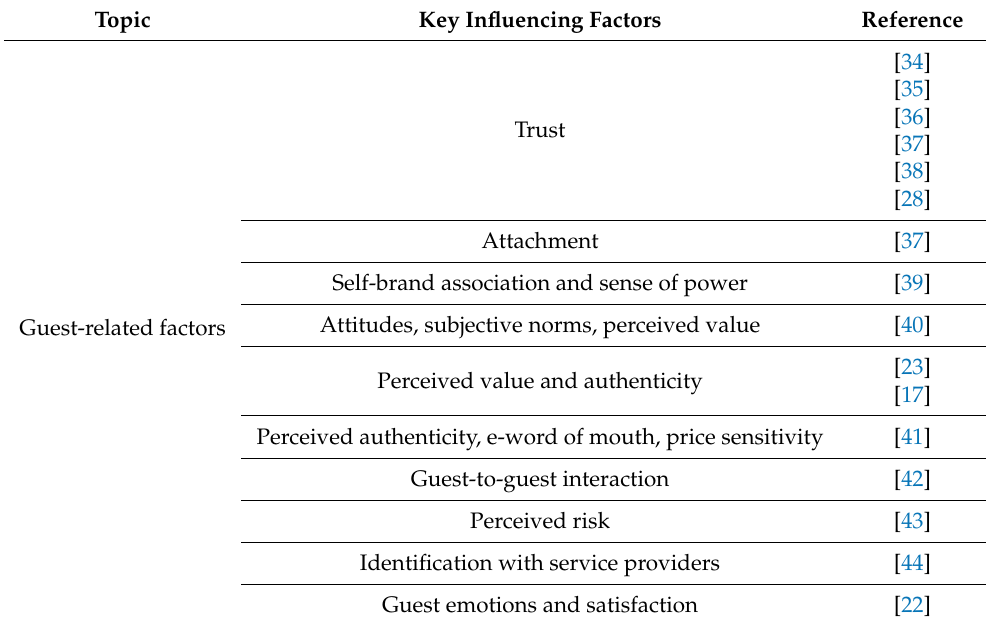
Table 1. Summary of extant research on booking behavior in shared